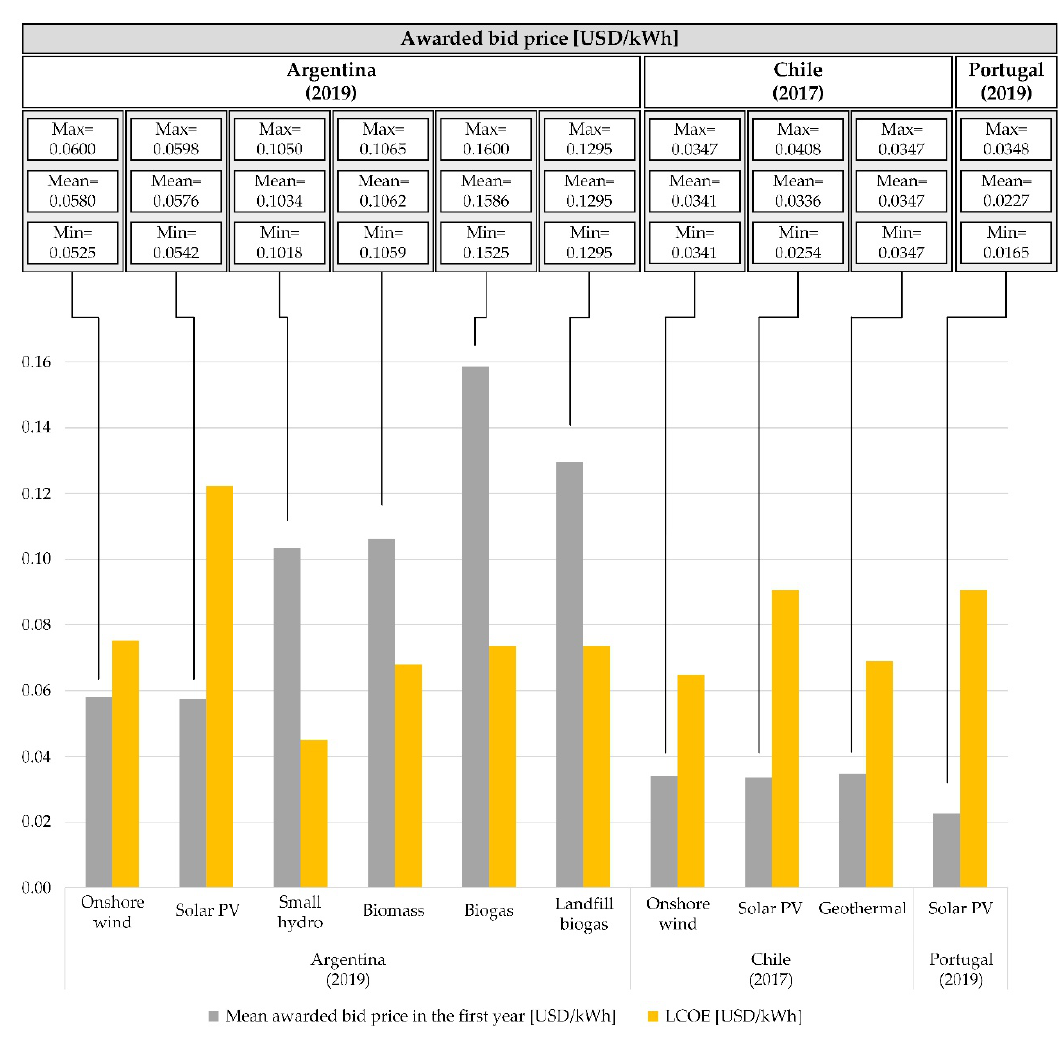
Figure 1. LCOE (yellow bars) versus power purchase agreements (PPA) price (grey bars) for the auctions from Argentina, Chile and Portugal listed in Table 1. Source: self ‐elaboration.